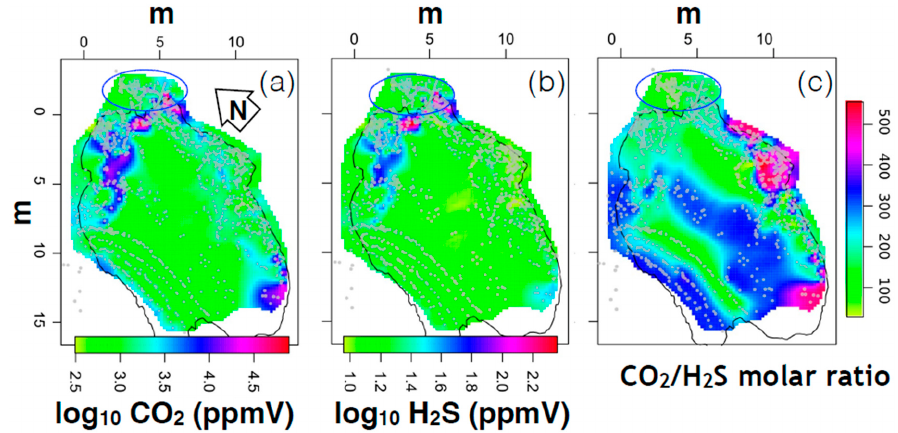
Figure 5. Integrated maps showing the CO 2 ( a ) and H 2 S ( b ) concentrations in the air above the Fangaia mud pool. Blue-purple-red colors coincide with stronger degassing areas. The map of CO 2 / H 2 S ratios ( c ) shows how the stronger degassing areas have the lowest CO 2 / H 2 S ratios. Highest CO 2 / H 2 S ratios are detected near the steep-walled shore of Fangaia’s basin. The blue-circle marks the area included in diffuse CO 2 flux measurements, the subaerial degassing area in June 2017, “m” indicates meters, for scale. Minerals 2020 , 10 , x